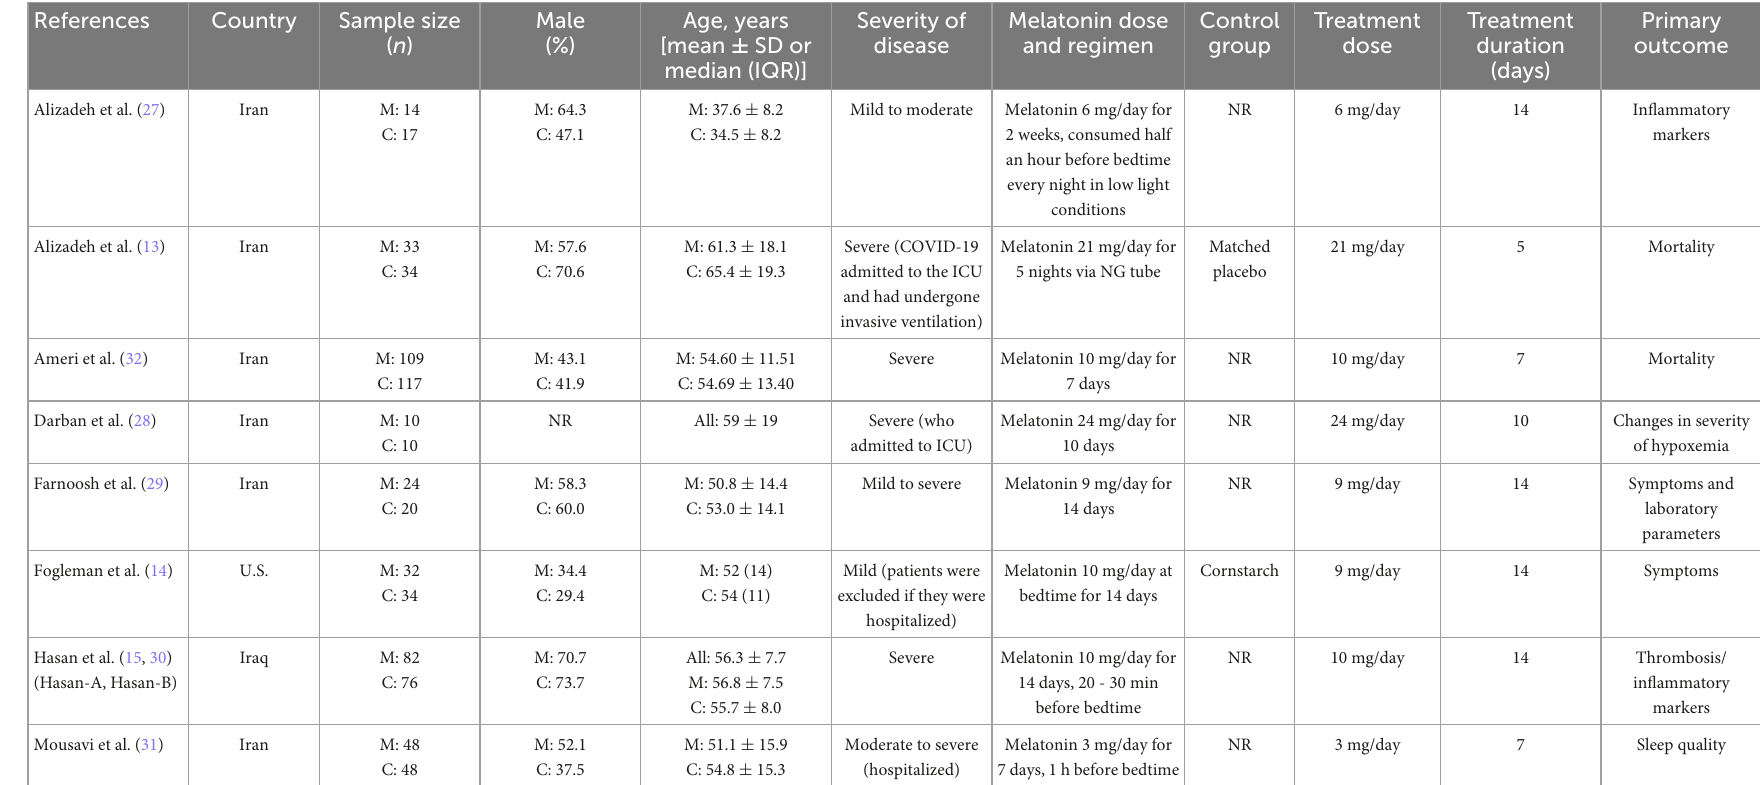
TABLE 1 Summary of the baseline characteristics of the included